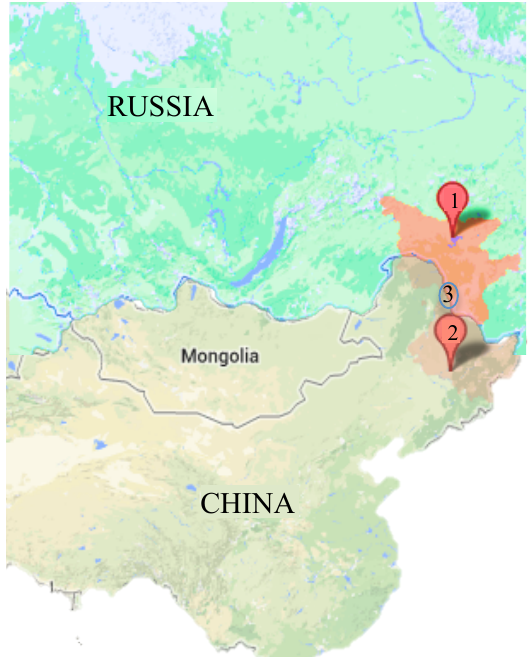
Figure 1. Map of Russian-Chinese borderland